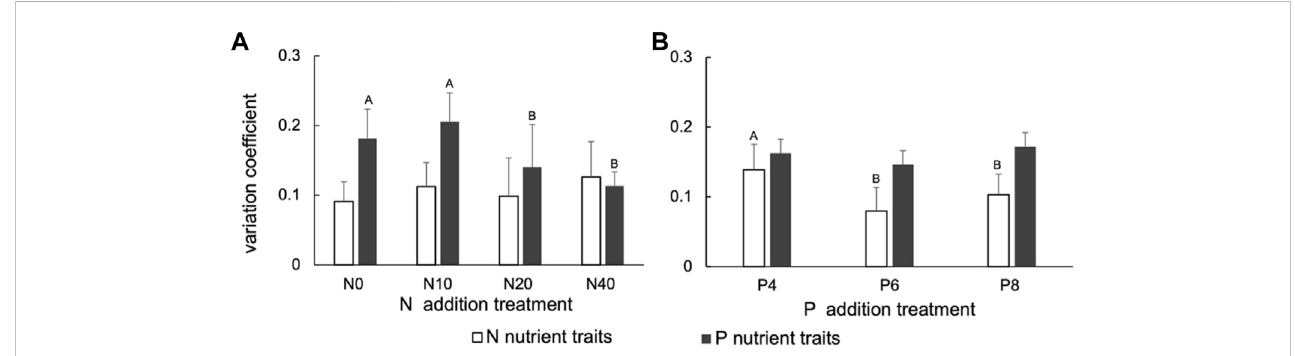
FIGURE 3 Coef fi cientofvariationofNandPcontentsin P.tanacetifolia under (A) Nadditiontreatmentand (B) Padditiontreatment.Differentcapitallettersindicate signi fi cant differences ( p < .05) between groups of CV of N and CV of P.